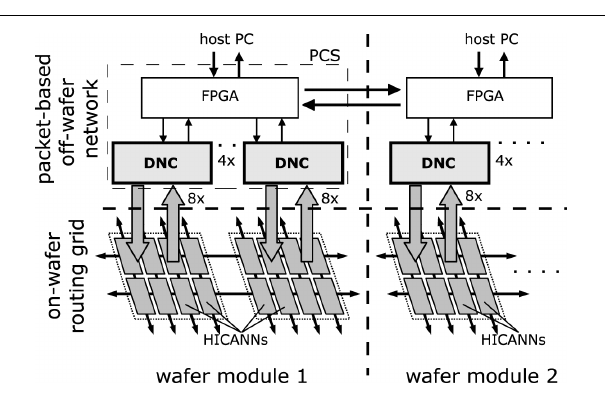
FIGURE 2 | Logical structure of the off-wafer packet-based network and the on-wafer routing